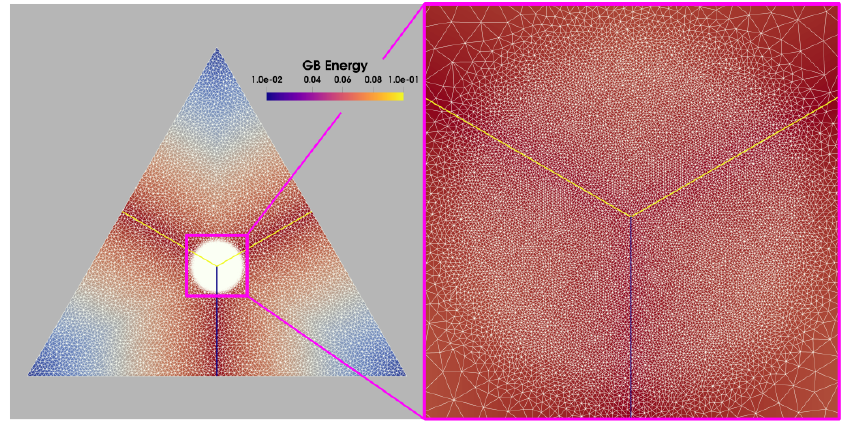
Figure A1. Initial configuration of the triangular case with a refined isotropic mesh around the triple junction and a coarse mesh outside the triple junction with r = 10.